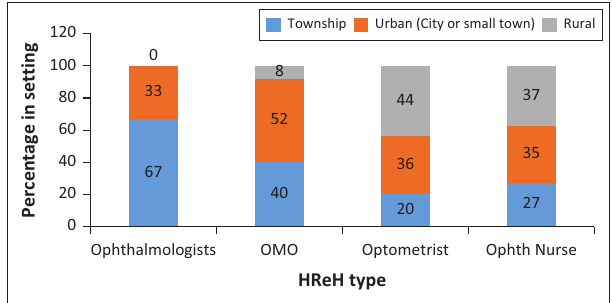
FIGURE 1: Distribution of human resources for eye health in different